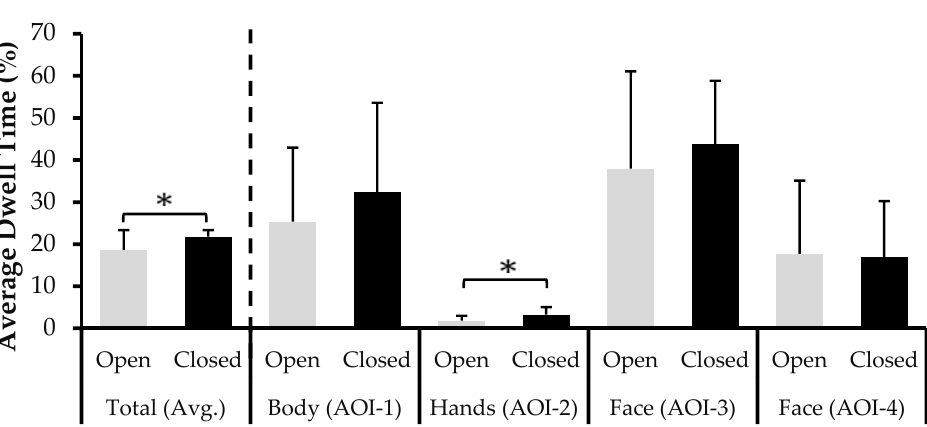
Figure 3. Average dwell time as a percentage of total looking time for each AOI split by judge Posture (error bars ± 1 SD). The line over the bars represents a significant difference (* p < 0.05).